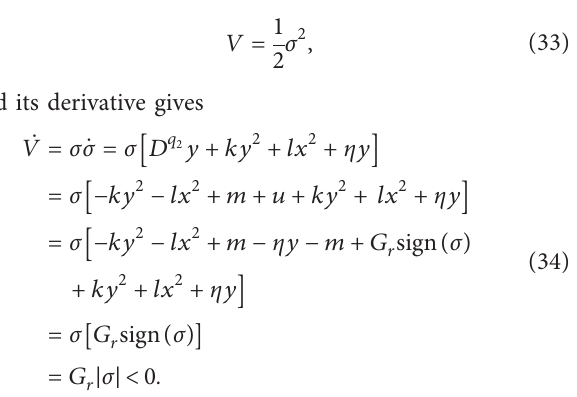
Figure 9: Phase diagrams showing the period-doubling route to chaos for system (6) with q � 0 . 87, (c) q � 0 . 878, and (d) q (b) q 3 3